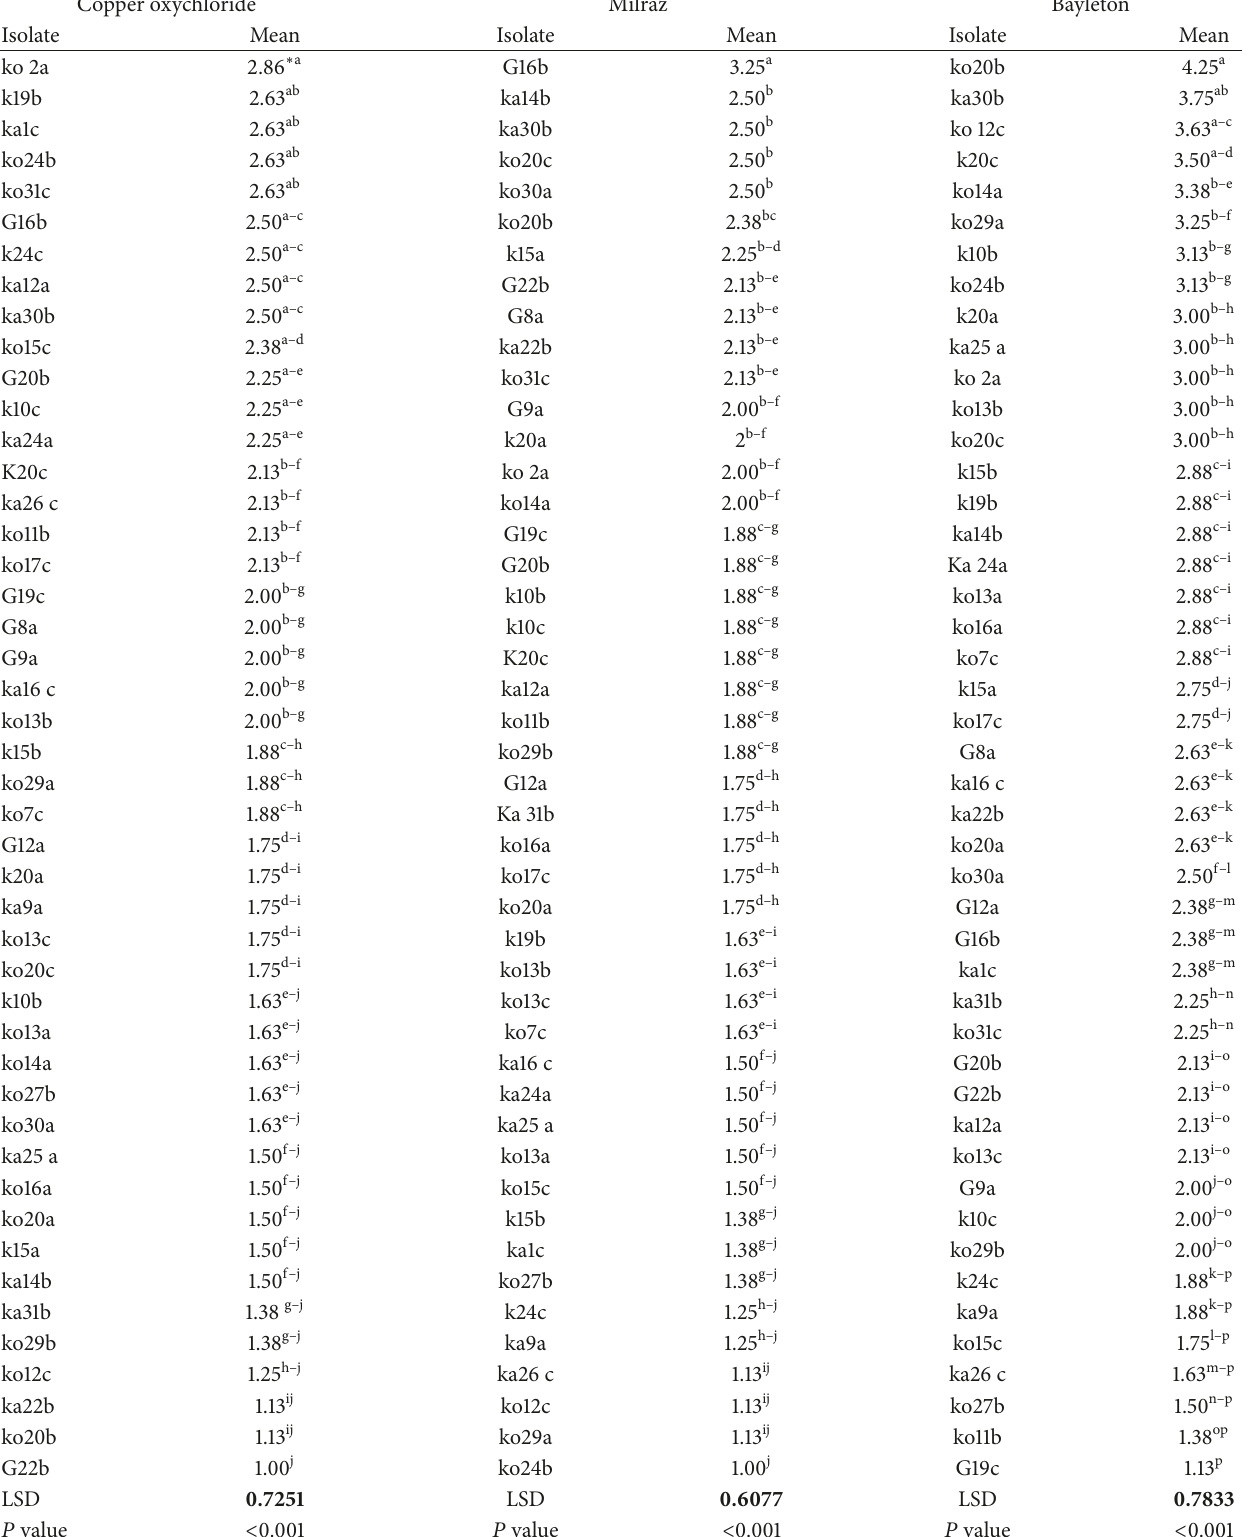
Table 3: Mean number of spores/ml from 46 Colletotrichum gloeosporioides isolates treated with three fungicides ( × 10 6 )/ml. Copper oxychloride